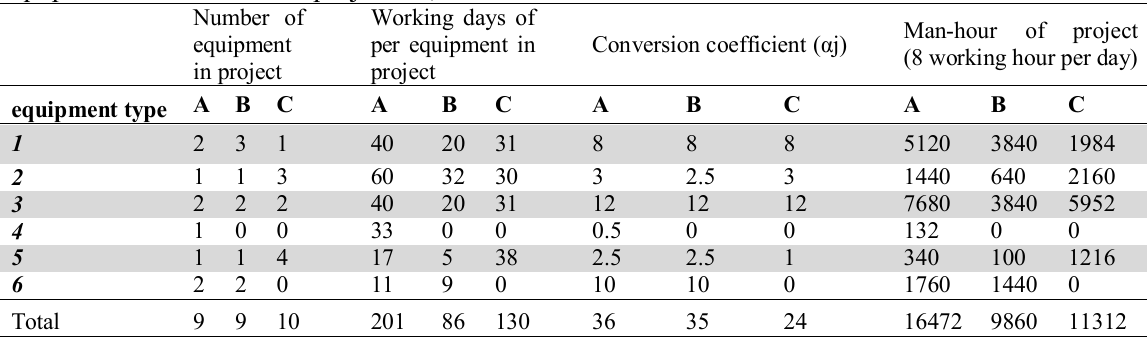
Equipment utilized in three projects A, B and C Number of Working days of equipment per equipment in in project project